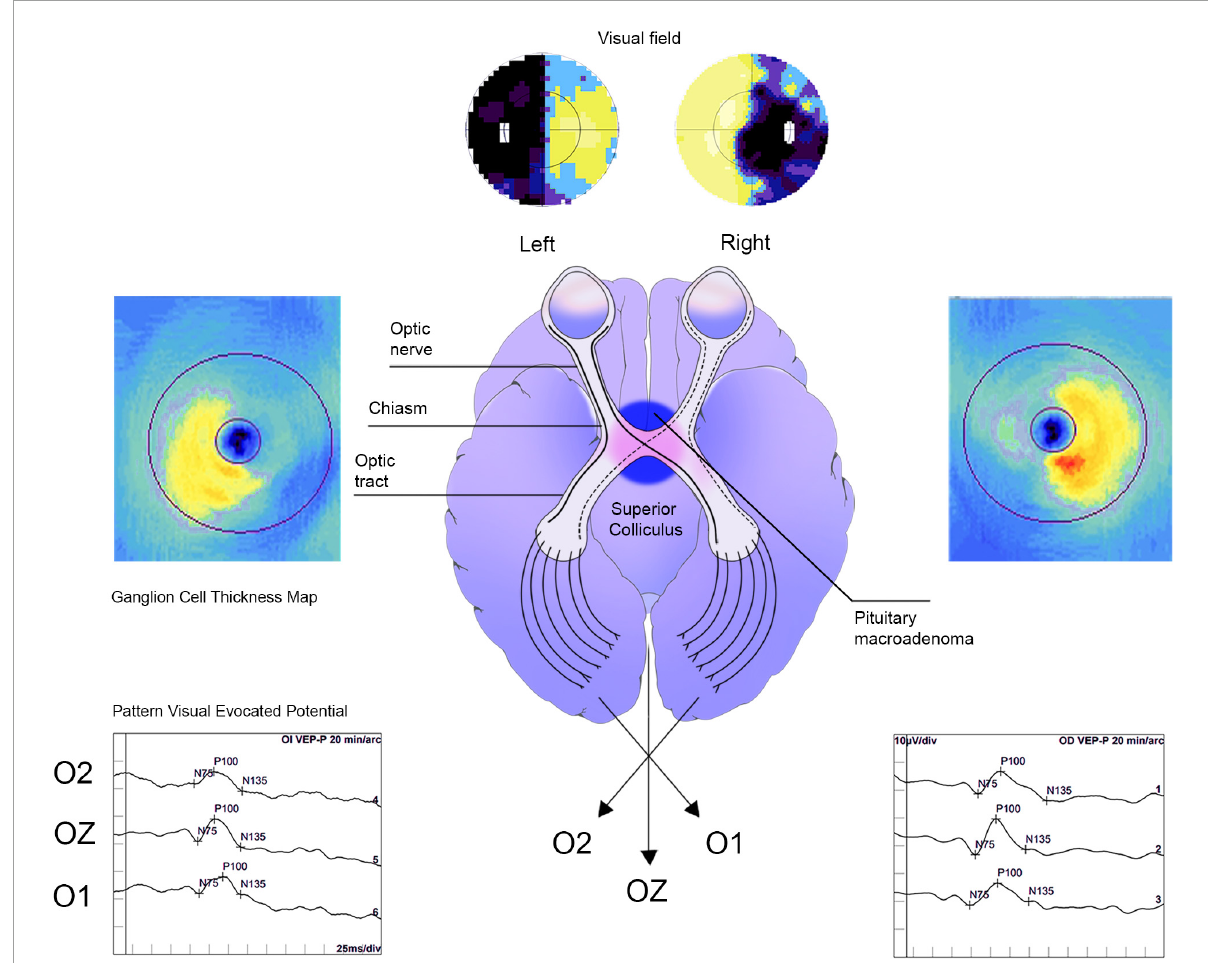
FIGURE1 Schematic representation of neuro-ophthalmological examination of a pituitary macroadenoma patient. The pre-surgical image is related to a 61-year-old patient. Bitemporal incongruent heteronymous hemianopia was observed in VF. Thickening of the global ganglion cell complex, particularly in the bi-nasal region and vertical meridian respect in the optical coherence tomography map, was also evidenced. In addition, visual evoked potentials displayed a latency delay and reduced amplitude of the P100